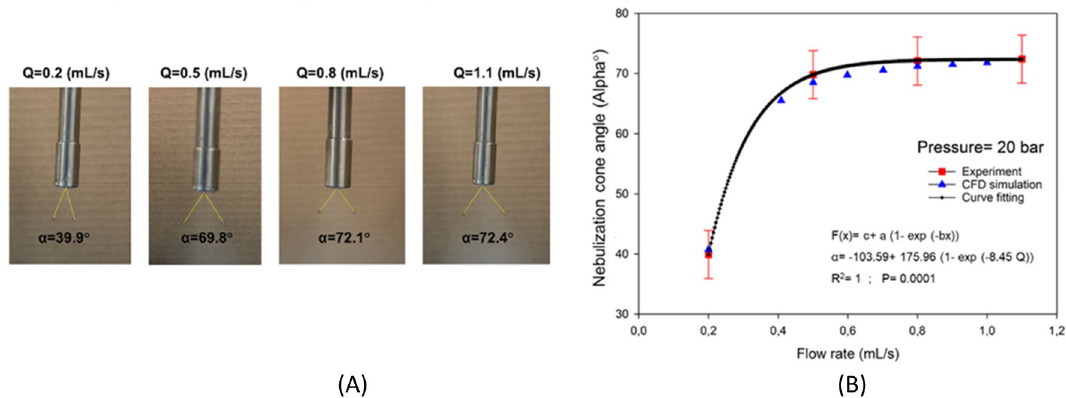
Figure 12. ( A ) The results of experiments to measure the cone angle of nebulization, and ( B ) A comparison of the results of experiments and CFD simulation for cone angle of nebulization and a curve fitting graph for trend of the results. (for the experiments, flow rates of 0.2, 0.5, 0.8 and 1.1 (mL s −1 ) and for the CFD simulations, flow rates of 0.2, 0.4, 0.5, 0.6, 0.7, 0.8, 0.9 mL s −1 and 1 mL s −1 were considered).